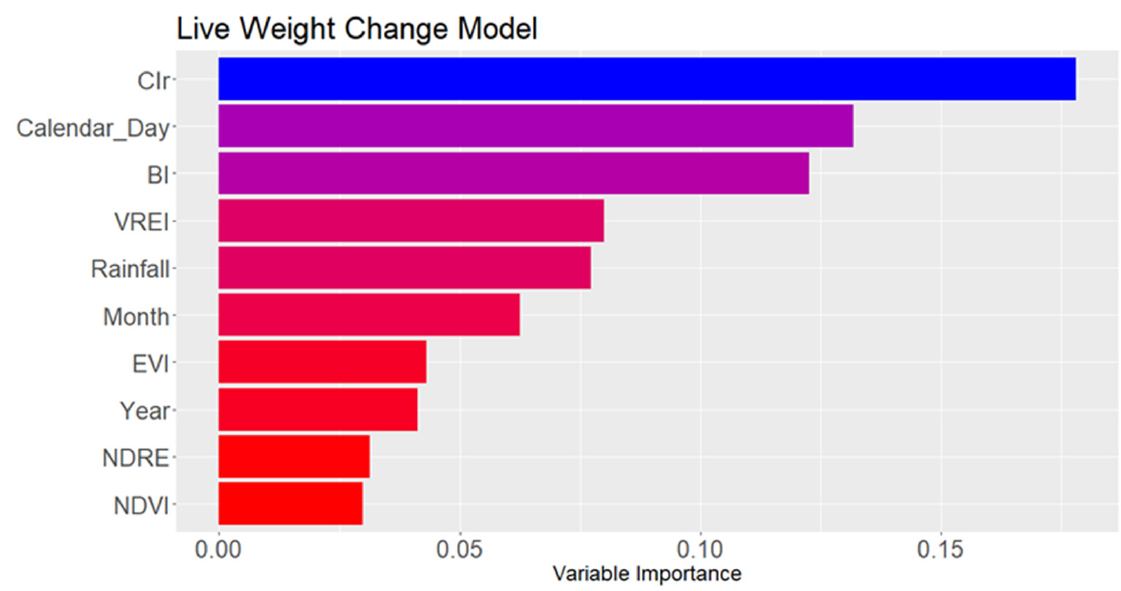
Figure 5. Variable importance of a random forest model predicting the live weight change of breeder cows under commercial conditions in northern Australia over a 2-year trial period. NDVI-Normalised Difference Vegetation Index; NDRE- Normalised Difference Red Edge; EVI- Enhanced Vegetation Index; CIr- Coloured Infrared; VREI- Vogelmann Red Edge Index; BI- Bare Soil Index; Rainfall- monthly cumulative rainfall data near trial site; Month- the numeric month of the trial from 1 to 24; Day- the Julian day of the trial for each year; Year- the numeric year of the trial,1 or 2.